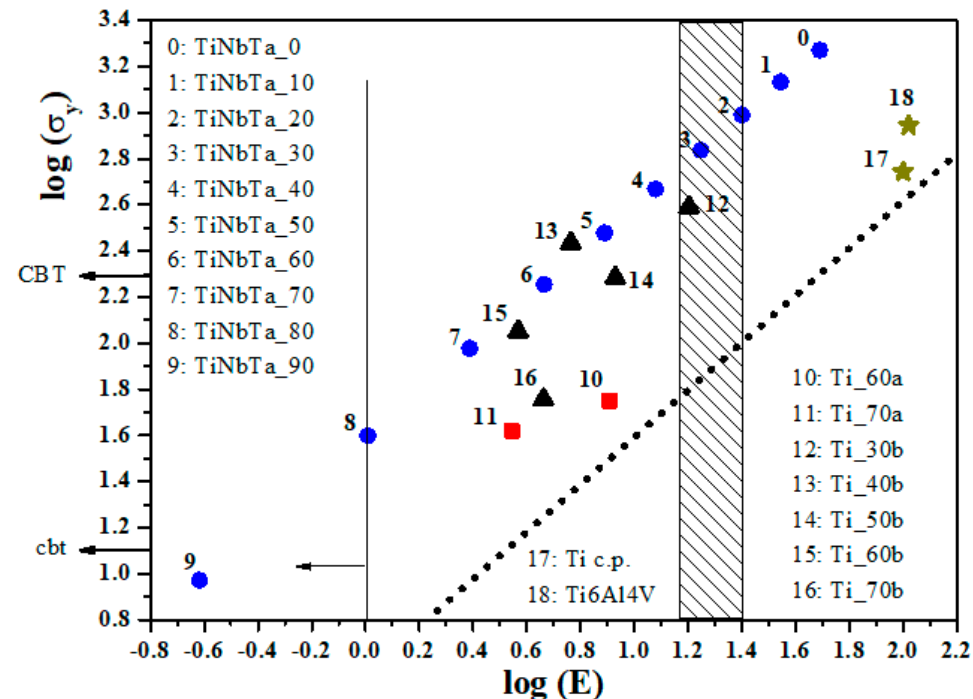
Figure 4. Comparison between elastic modulus (E) and yield strength ( σ y ) for: ( a ) the developed fully dense TiNbTa material and the corresponding porous TiNbTa ( • ); ( b ) Ti foams (fabricated by the space-holder, using sodium chloride (NaCl) ( ν ), and ammonium bicarbonate (NH 4 HCO 3 ) ( ▲ ); ( c ) commercial Ti c.p. (number 17) and commercial Ti6Al4V (number 18). The striped column marks the limits between the interval E values for cortical bone tissues. In turn, the E values for cancellous bones (less than 1 GPa) are marked with the continuous line and the arrow to the left. CBT and cbt: maximum value of yield strength for cortical (CBT) and cancellous (cbt) bone tissues, respectively. In addition, for comparison purposes, the dotted line marks the slope line equal to 1 to observe the specimens that maximize the index σ y /E.